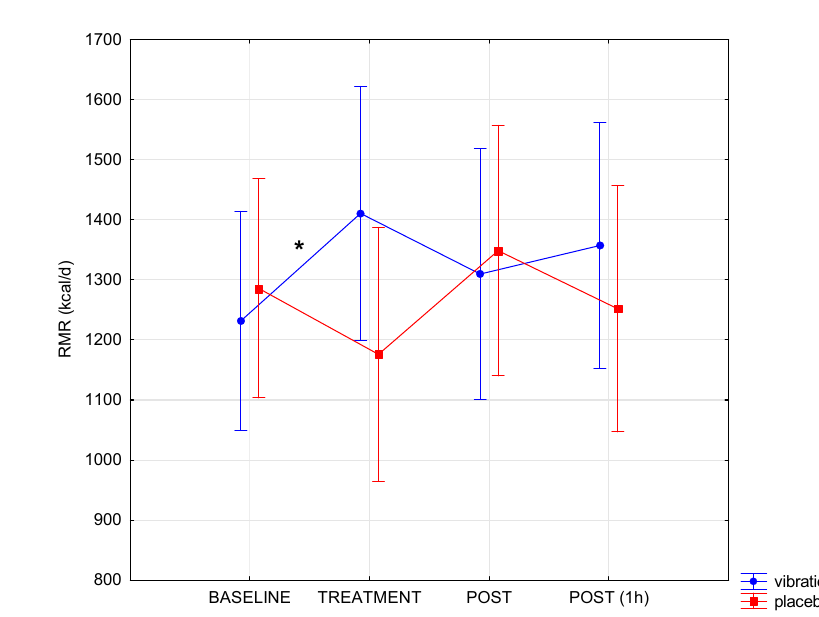
Figure 3. Changes in resting metabolic rate (RMR) pre- (baseline), during (treatment) and post-vibration (* significant change compared to baseline in WBV group). The data are presented as mean and 95% CI.